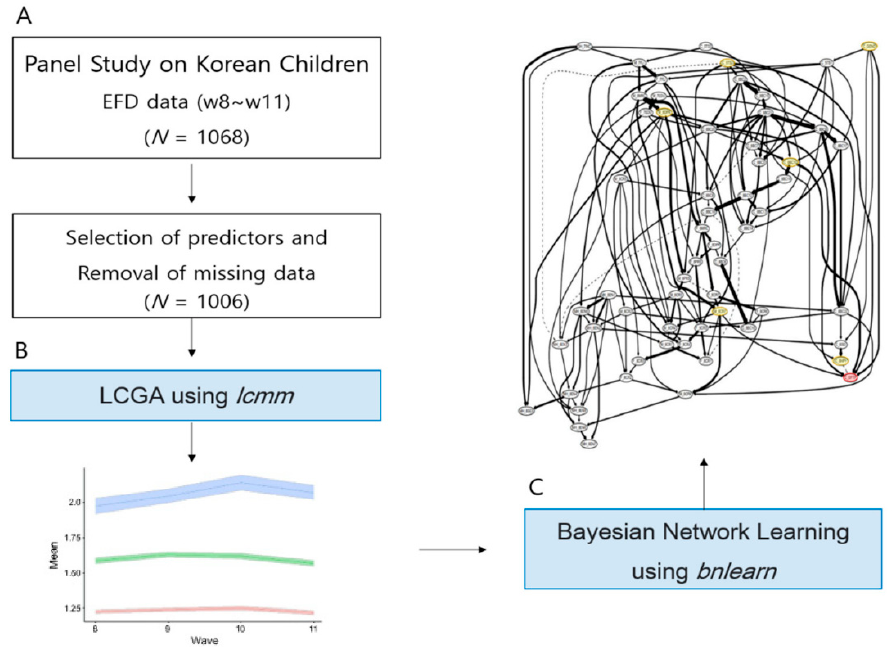
Figure 1. Schematic view of the methodology. ( A ) As a sample selection step, samples with no missing EF longitudinal data and predictors were selected for four years, after which samples with missing values were removed. ( B ) The longitudinal latent layer of EF was confirmed using the lcmm package. The pink line is class 1, the green line is class 2, and the blue line is class 3. ( C ) Using the BNL algorithm with the bnlearn and bootnet package, probabilistic prediction models for classifying EF latent layers were developed, and the performances of the classification models were compared and analyzed. The red circles are the Effect nodes (C_EFPT) of model 4 (threshold = .85) and the yellow circles are the parent nodes (C_GEND, C_5TS2, C_8HPY, C_8BC10, M_8DPR,